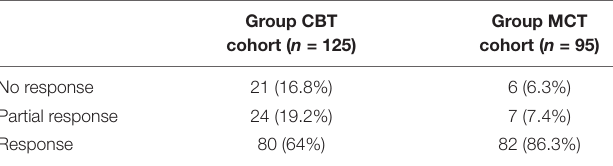
TABLE 3 | Proportion of patients achieving criteria for response, partial response and no response on Y-BOCS scores at post-treatment for the group treatment